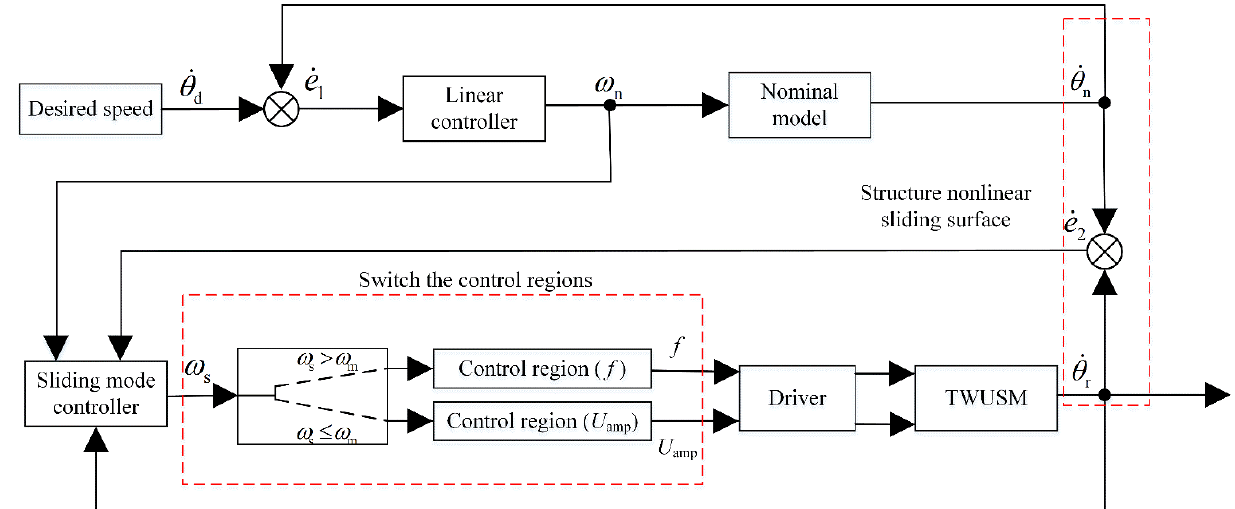
Figure 4. Block diagram of NMSMC for TWUSM.